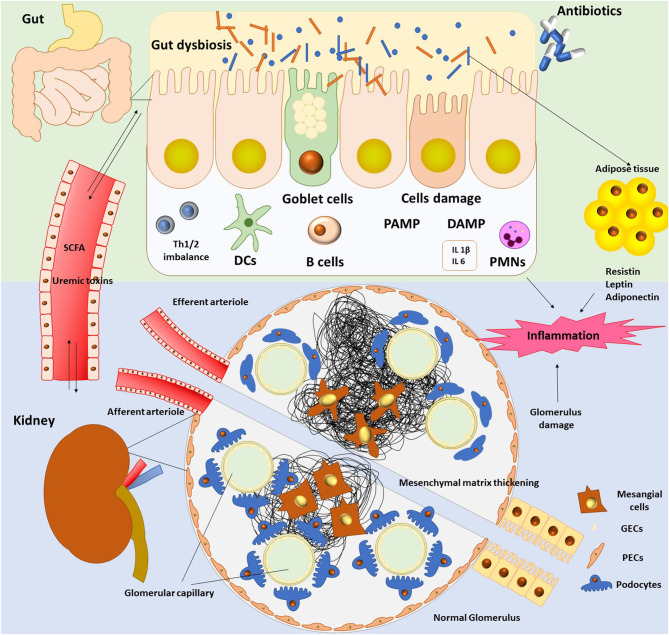
The gut–kidney axis.